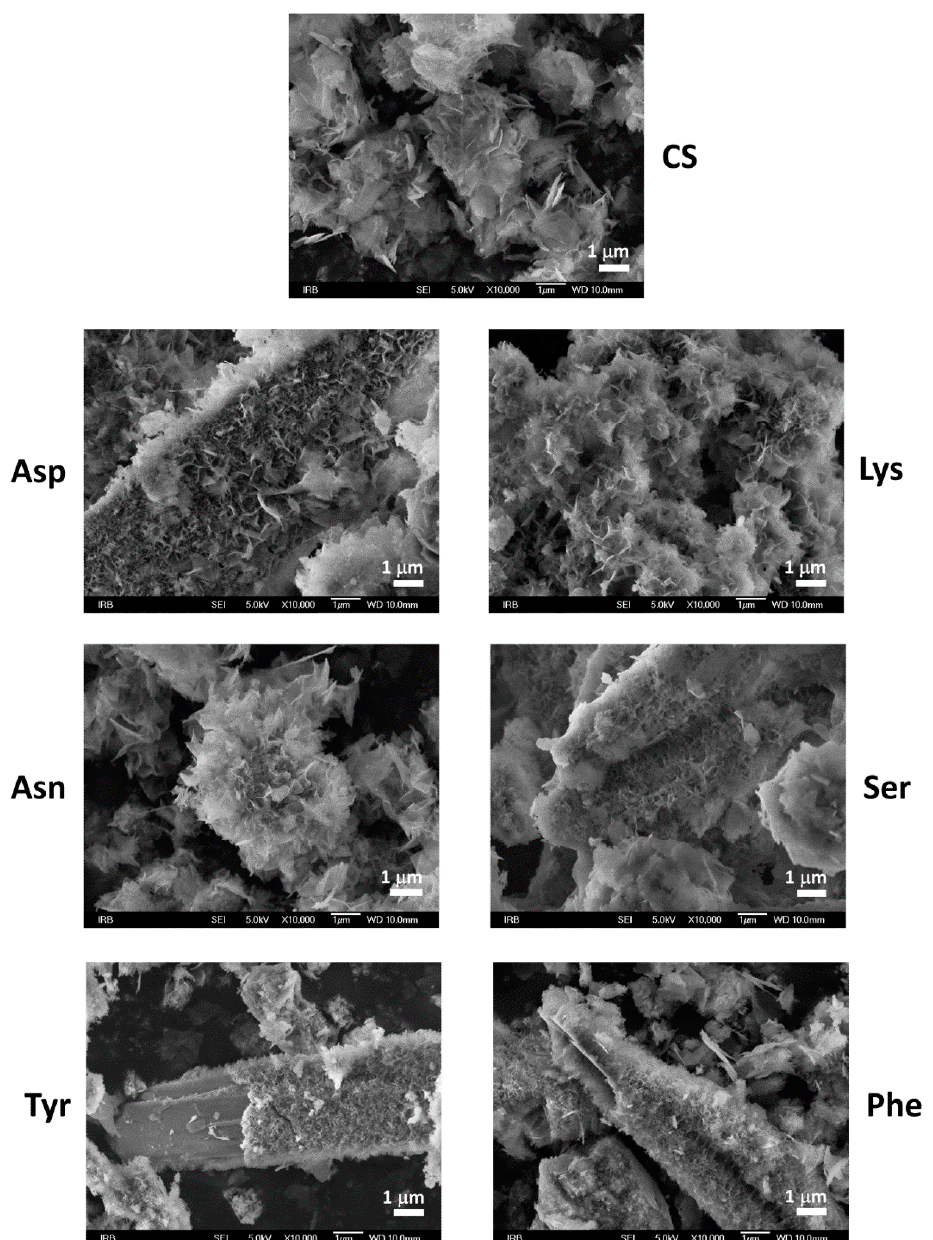
Figure 4. SEM micrographs of precipitates formed in the control system (CS) and in the presence of different amino acids after 240 min aging time in the system c( CaCl 2 ) = c (Na 2 HPO 4 ) = 4.198 mmol dm − 3 , c (NaCl) = 0.148 mol dm − 3 , m (seed OCP) = 1 mg, γ (AA) = 10 ppm, except γ (Phe) = 5 ppm. t = 25 ◦ C, pH initial = 7.4, magnetic stirring. Asp—L-aspartic acid, Tyr—L-tyrosine, Asn—L-asparagine, Lys—L-lysine, Ser—L-serine,